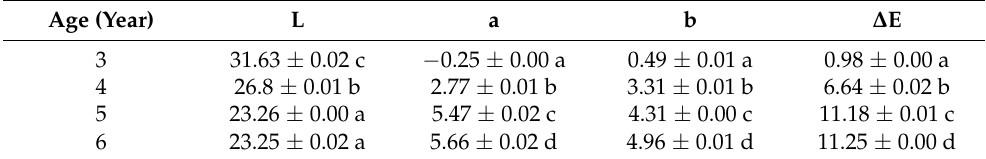
Table 3. Colorimetric parameters of ginseng extract of different ages.